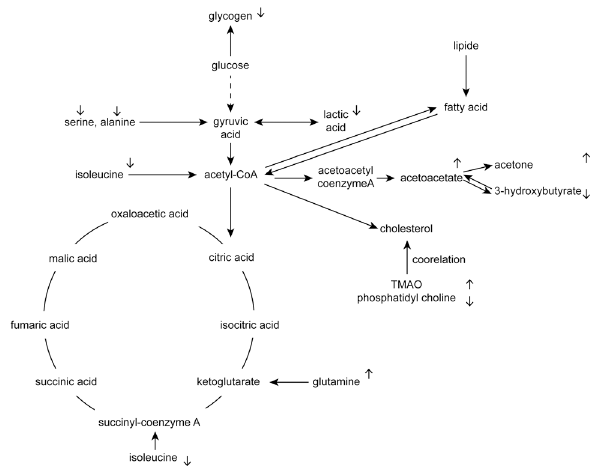
Figure 5. Summary of the metabolic pathways related to the metabolites that changed significantly in the hyperlipidemia model. “↑” and “↓” indicate that the compound is up- and down-regulated compared with the control group.